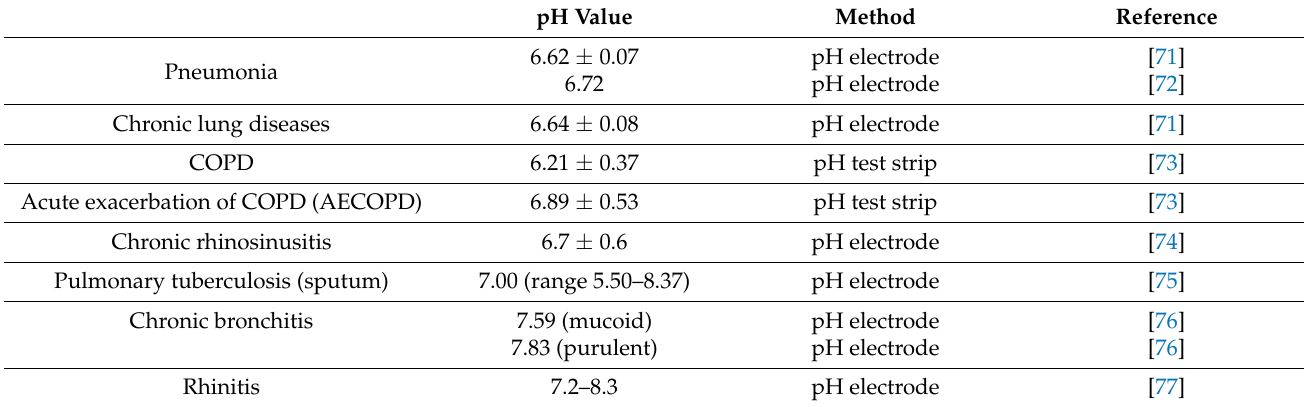
Table 4. ASL pH in vivo measurements of human samples in patients with diseases other than cystic